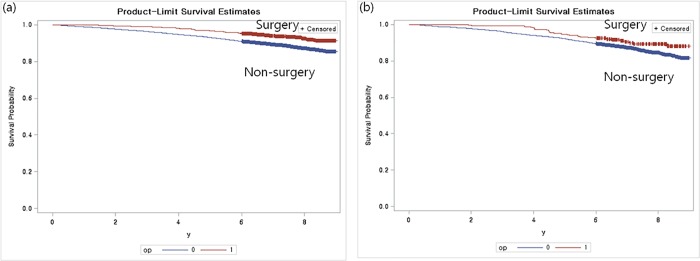
Surgical outcomes in (a) LSS and (b) LSS with DM by Kaplan-Meier analysis. DM, diabetes mellitus; LSS, lumbar spinal stenosis.